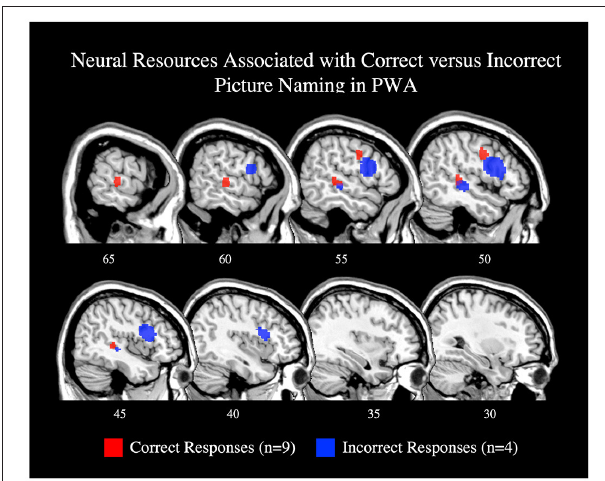
FIGURE 7 | Representative sagittal slices for the ALEs associating picture naming activation with correct responses (red) and incorrect responses (blue; p < 0.001 corrected). Only the right hemisphere is depicted. Sample size denotes the number of tasks included in the